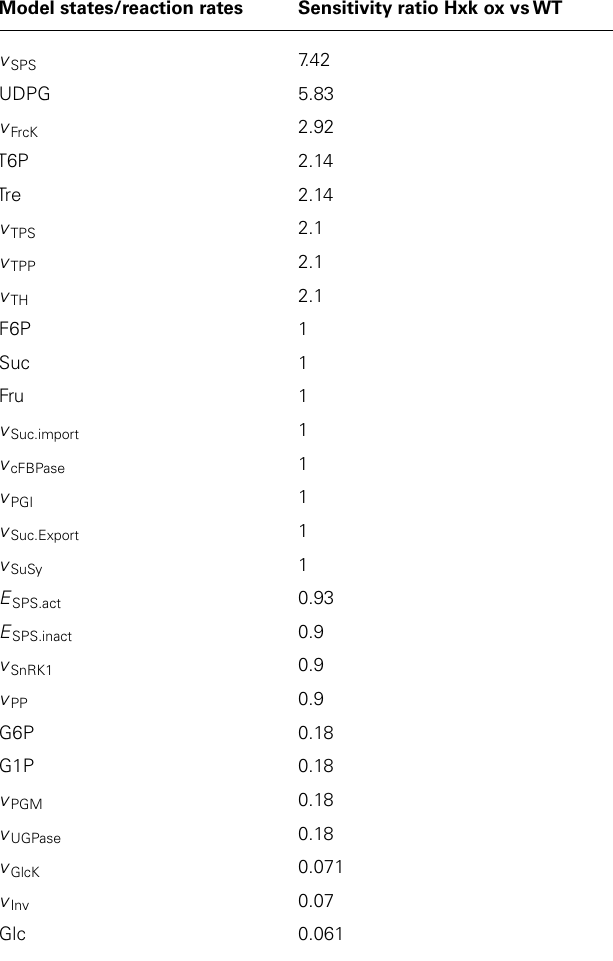
Table 1 | Changes in sensitivities to perturbation in external sucrose supply due to Hxk overexpression. Model states/reaction